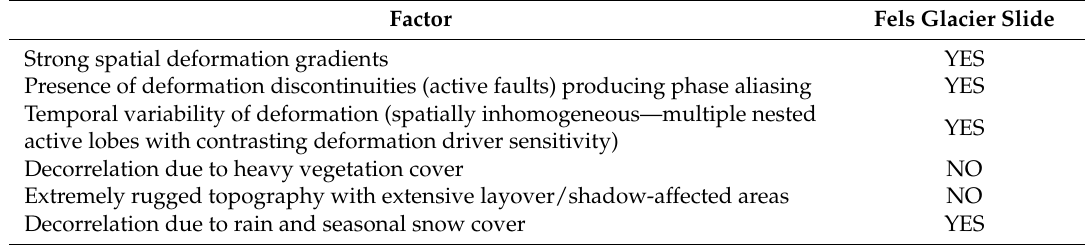
Table 1. Complicating factors to the successful phase unwrapping/demodulation of landslide interferograms and the relevance of the Fels Glacier Slide example. Factor Fels Glacier